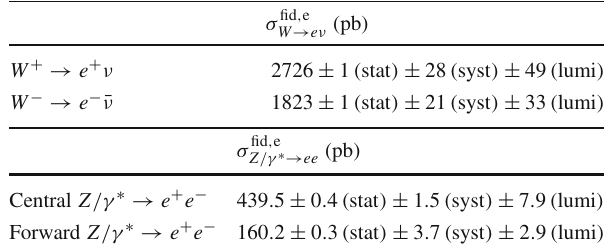
Table 2 Fiducial cross sections times branching ratios for W + , W − , central and forward Z /γ ∗ (66 < m ee < 116GeV) production in the electron decay channels. The fiducial regions used for the measurement are those defined for the combined fiducial regions in Sect. 2.3, except thatthecentralelectronpseudorapidityisrestrictedtobe | η | < 2 . 47and excludes 1 . 37 < | η | < 1 . 52, and the forward electron pseudorapidity excludes the region 3 . 16 < | η | < 3 . 35. The uncertainties denote the statistical (stat), the systematic (syst) and the luminosity (lumi) uncer-